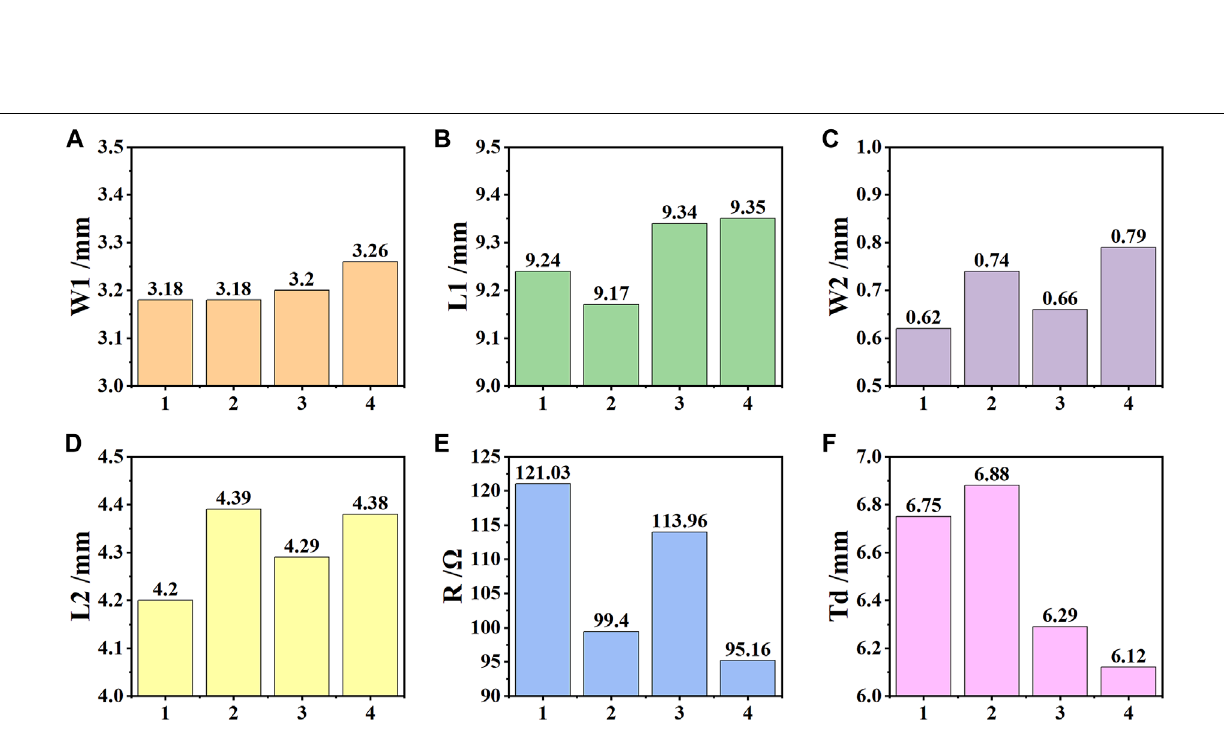
FIGURE 5 | Schematic diagram of partial results at 5.5 ∼ 12 GHz. The horizontal axis represents the design scheme number, and the vertical axis is the specific parameters of each design scheme. (A) The designed results of W 1 . (B) The designed results of L 1 . (C) The designed results of W 2 . (D) The designed results of L 2 . (E) The designed results of R. (F) The designed results of T d